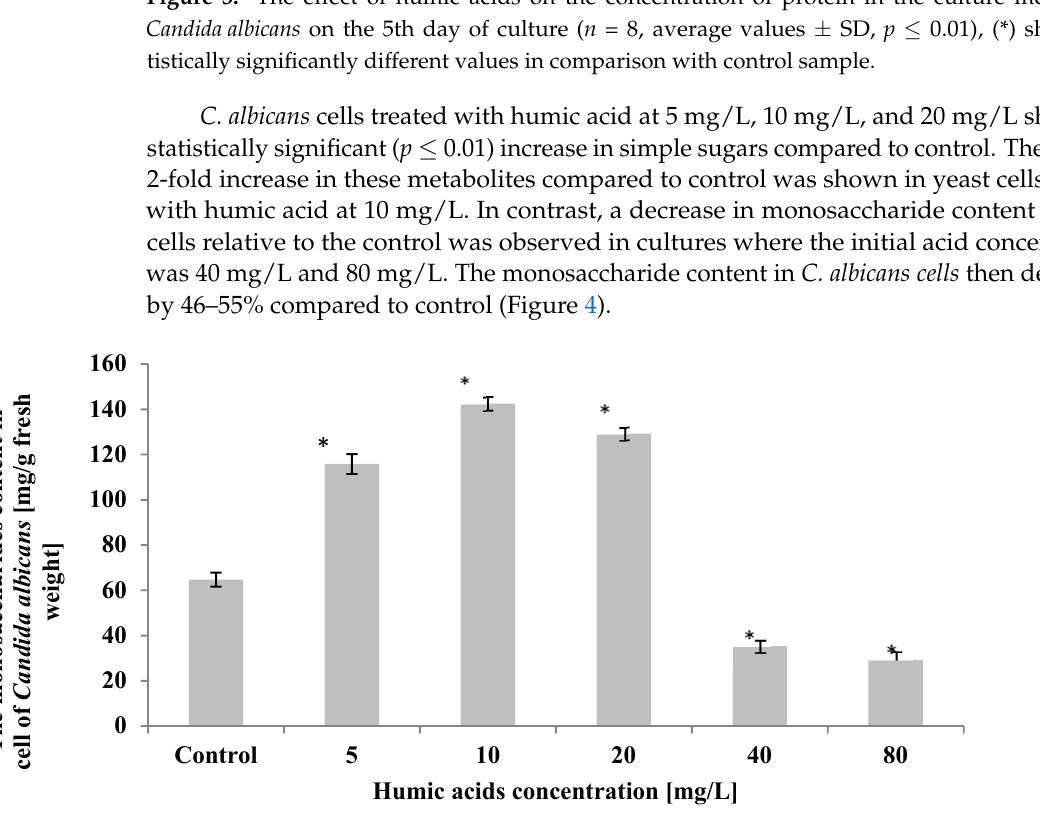
Figure 4. The effect of humic acids on the monosaccharaides content in cell of Candida albicans in the 5th day of culture ( n = 8, average values ± SD, p ≤ 0.01), (*) shows statistically significantly different values in comparison with control sample.